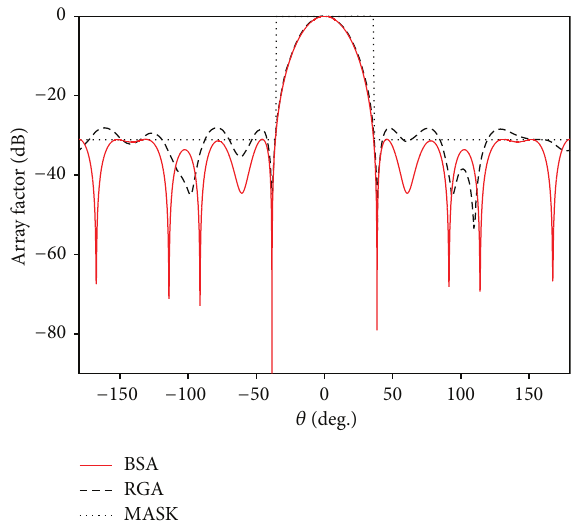
Figure 5: The radiation patterns obtained by BSA and PSOCFIWA [1] for CCAA without central element.